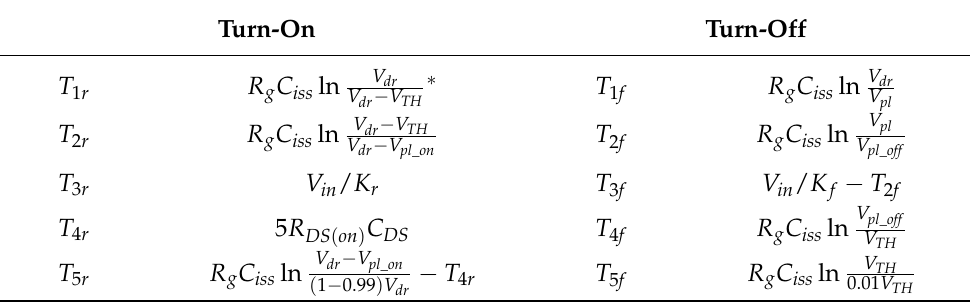
Table 1. Duration of each interval of the switching process of a power MOSFET with a clamped current